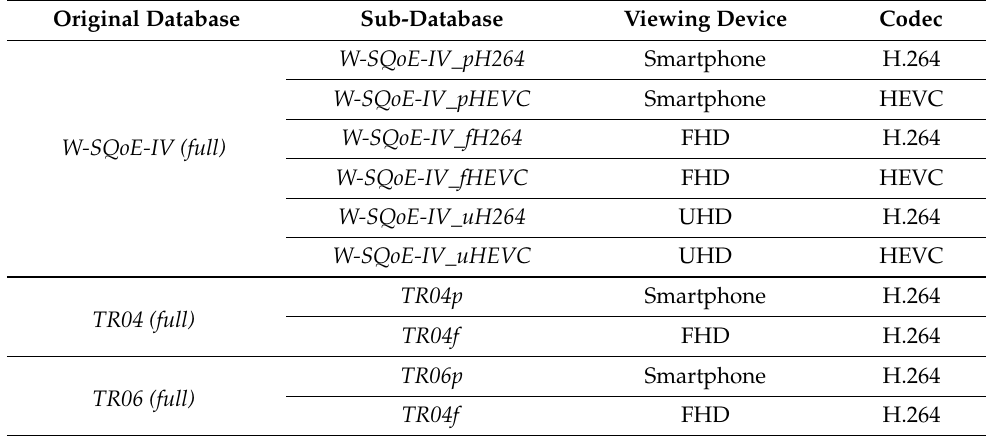
Table 2. Settings of